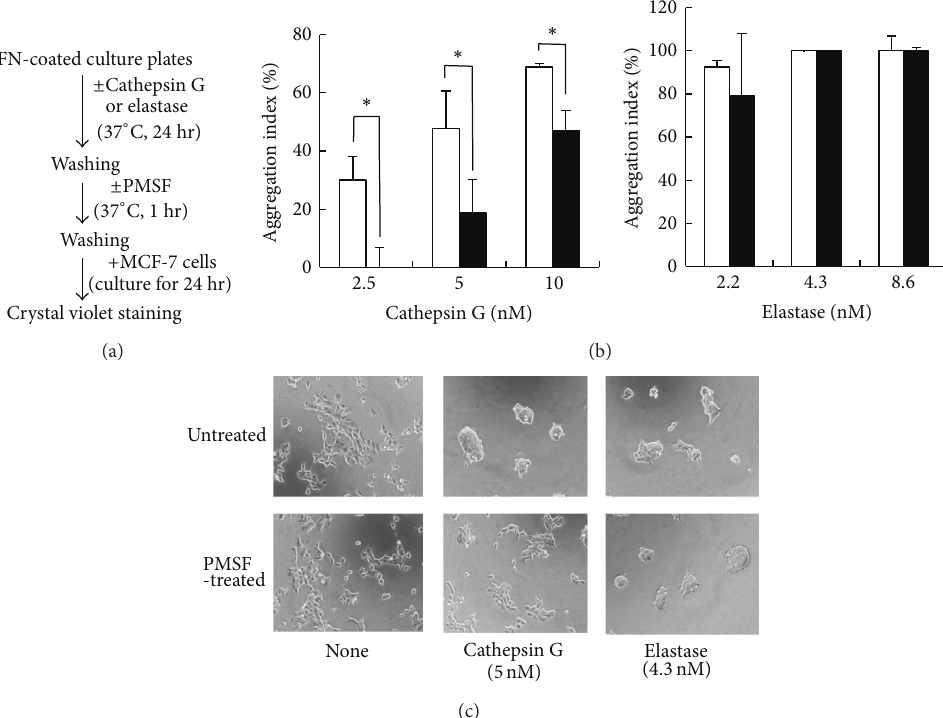
Figure 5: Effect of PMSF treatment against protease-treated FN-coated wells on the induction of MCF-7 cell aggregation. (a) Experimental scheme. Cathepsin G or elastase was added to FN-coated wells as indicated. After 24h of incubation, the wells were treated without or with PMSF (4mM) at 37 ∘ C for 1h. Then, MCF-7 cells suspended in 1% BSA-medium were seeded and incubated for 24 h. The cell aggregation index was evaluated as described in the legend of Figure 2. (b) Open columns: without PMSF treatment (vehicle control); filled columns: with PMSF treatment. The results are expressed as the mean ± SD ( 𝑛 = 3 ). Asterisk indicates that the values are significantly different according to the Student’s t -test ( 𝑃 < 0.05 ). (c) Images of MCF-7 cells at 24h after cultivation in protease/PMSF-treated FN-coated wells. Original magnification: ×